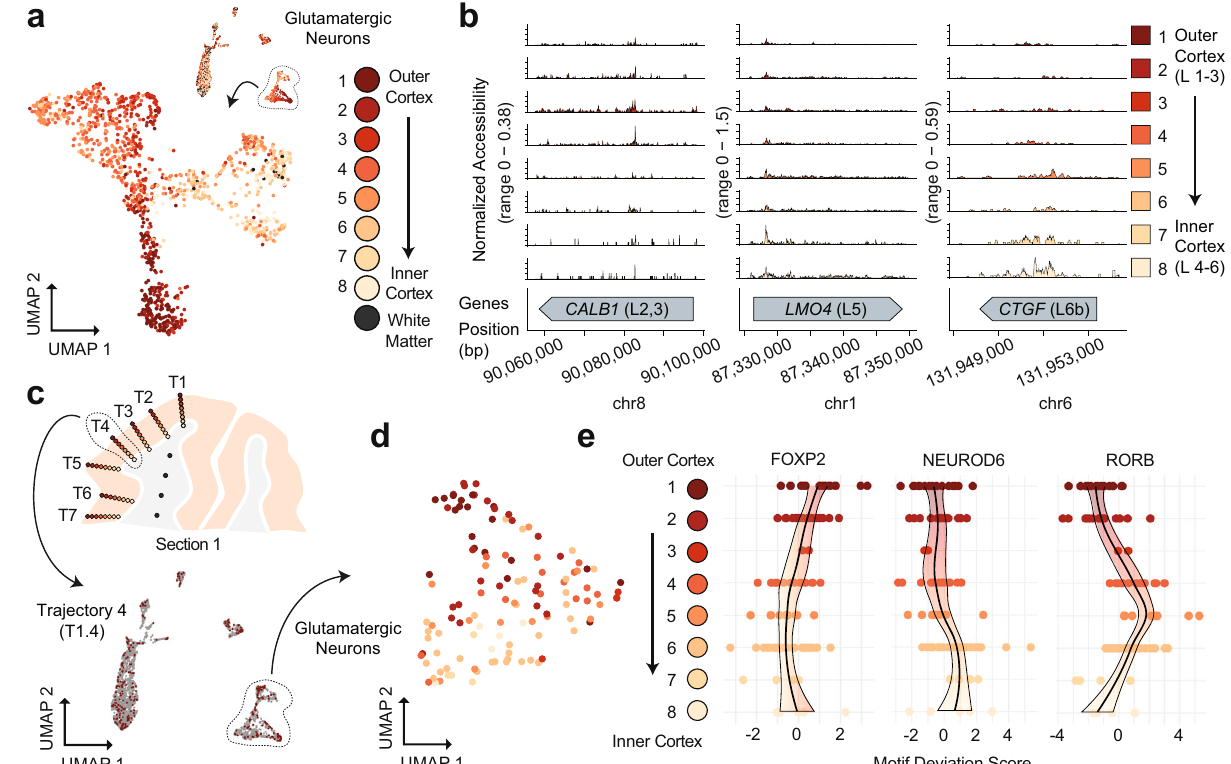
Fig. 6 sciMAP-ATAC shows spatial epigenetic patterns of glutamatergic neurons. a Isolation and UMAP visualization of human VISp glutamatergic neurons from all cells (top right), colored by punch position. An interactive, three-dimensional UMAP embedding is available as Supplementary Data 4. b ATAC-seq pro fi les for glutamatergic neurons along trajectory positions for layer (L)-speci fi c marker genes CALB1 (layers 2 and 3), LMO4 (layer 5), and CTGF (layer 6b); colored by punch position as in a . c Cells from section 1, Trajectory 4 (T1.4, top) are shown in color on the UMAP of all cells, with other cells shown in gray (bottom); colored by position as in a . d UMAP of glutamatergic neurons from Trajectory 1.4 after topic modeling on the isolated cells; colored by position along the trajectory as in a . e DNA-binding motif enrichment for layer-speci fi c factors for Trajectory 1.4 shown in d , with cells split by their positions along the trajectory. Source data are provided as a Source data fi